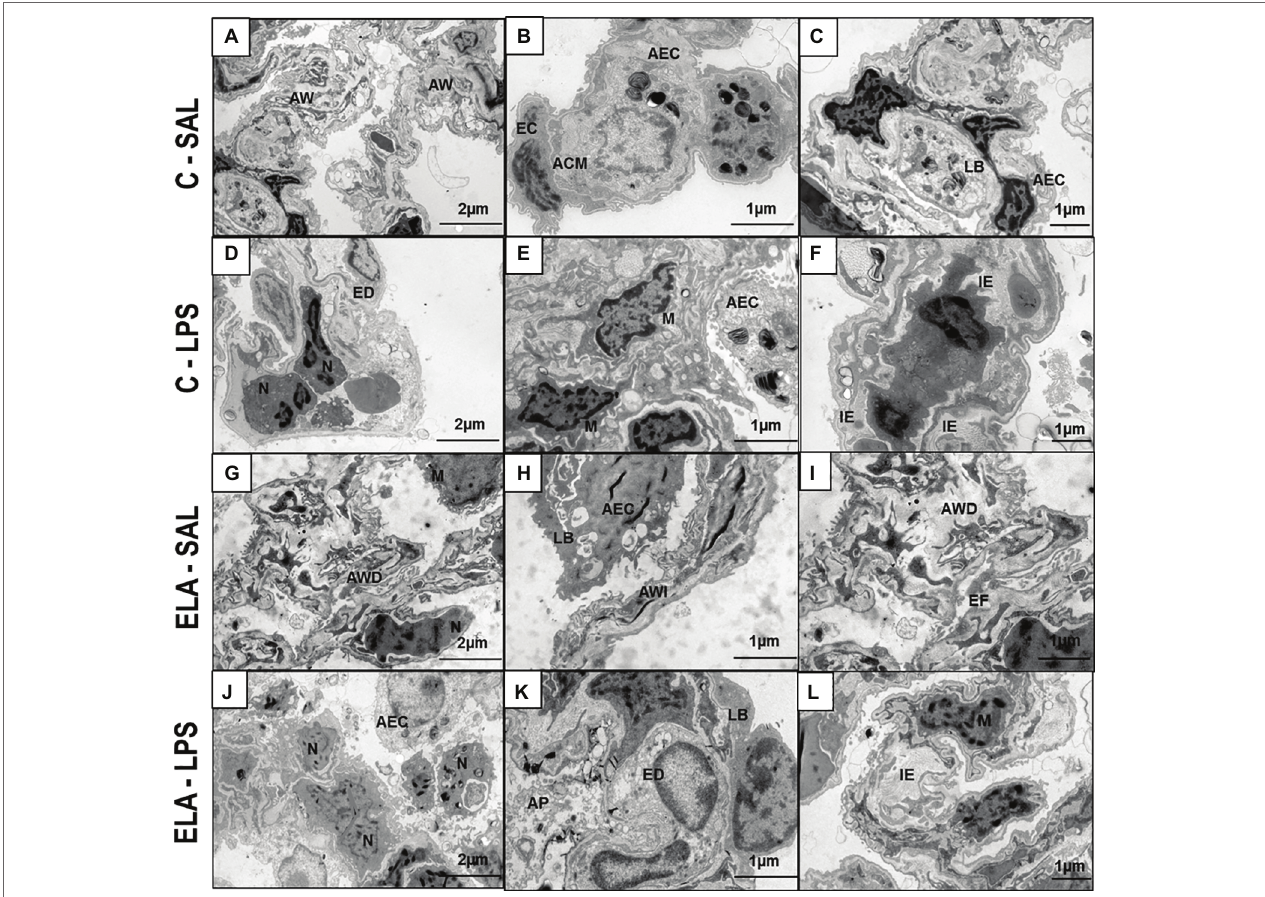
FIGURE 3 | Transmission electron microscopy of lung parenchyma in control (C) and animals exposed to saline (A–C) or E. coli LPS (D–F) , as well as in emphysema (ELA) rats exposed to saline (G–I) or E. coli LPS (J–L) . Note preserved alveolar walls (AW), integrity of endothelial cells (EC) of the alveolar–capillary membrane (ACM), and lamellar bodies (LB) of alveolar epithelial cells (AEC) in the C-SAL group. C-LPS animals show collapse of AW with increased neutrophil (N) and macrophage (M) counts, endothelial-cell damage (ED), detachment of AEC with increased permeability of the alveolar–capillary membrane, and interstitial edema (IE). ELA-SAL animals show alveolar wall disruption (AWD) and irregularity (AWI), inflammation, and destruction of elastic fibers (EF). The pattern of inflammation involves increased numbers of neutrophils (N) and macrophages (M). These cells produce proteases involved in tissue destruction and release local and systemic inflammatory mediators, which amplify inflammation and structural disruption. Note detachment of AEC and reduction in LB. After emphysema exacerbation, there is an increase in neutrophil (N) and macrophage (M) response, increased detachment of AEC, loss of LB, and ED, causing increased permeability of the alveolar–capillary membrane and IE due to surfactant